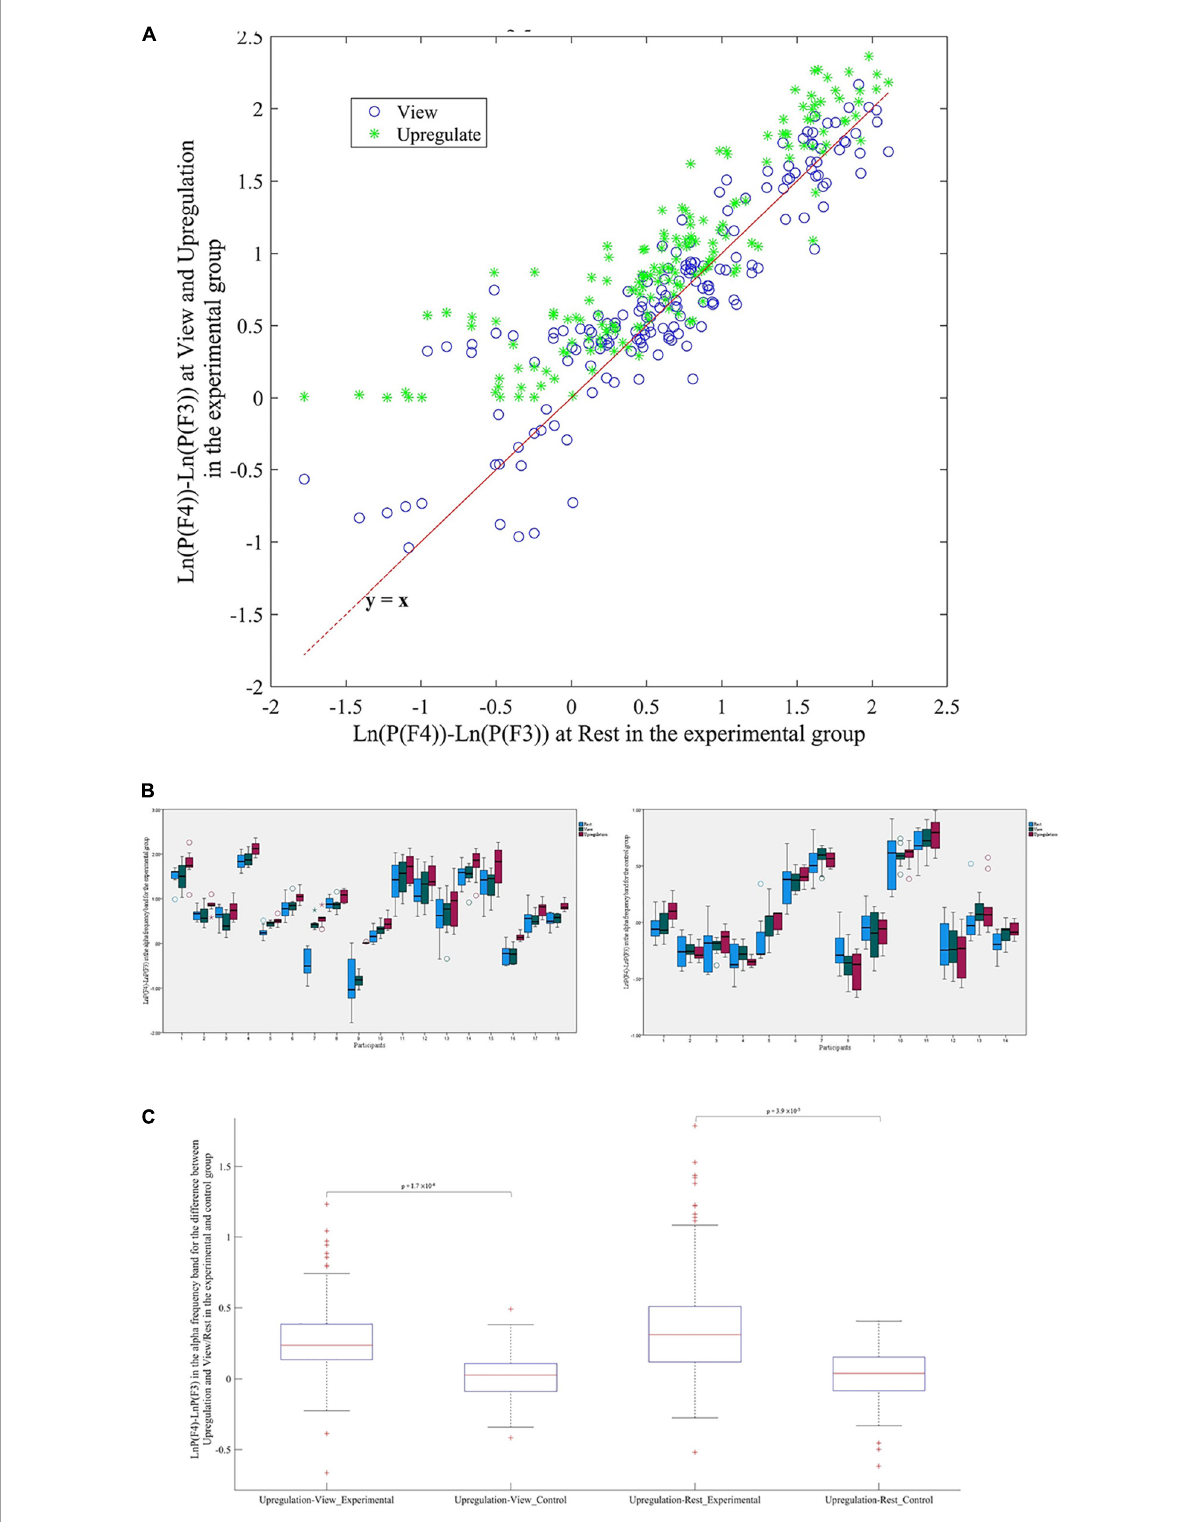
FIGURE2 (A) Scatter plot of frontal asymmetry in blocks of View and Upregulation versus Rest for the experimental group. (B) Boxplot of frontal asymmetry in blocks of Rest, View, and Upregulation for the experimental and control groups. (C) Boxplot of frontal asymmetry for Upregulation versus View and Rest in the experimental and control